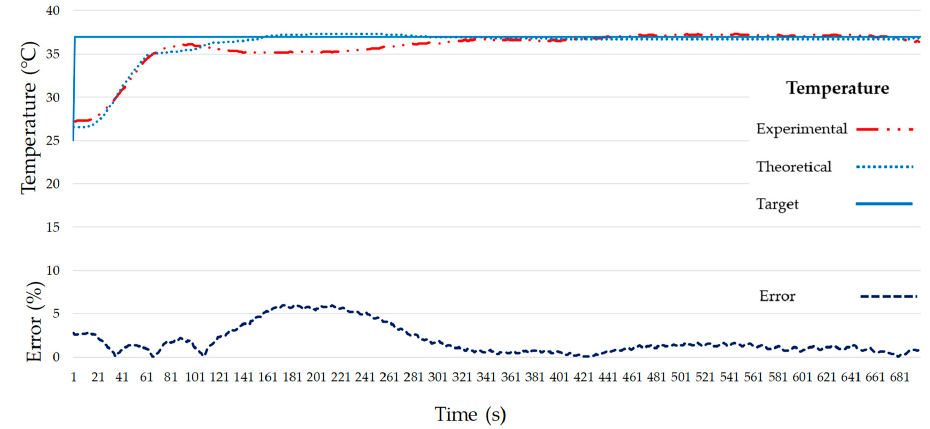
Figure 12. Target, model and experimental temperature ( top ) and experimental temperature error ( bottom ) of the final atmospheric enclosure system.